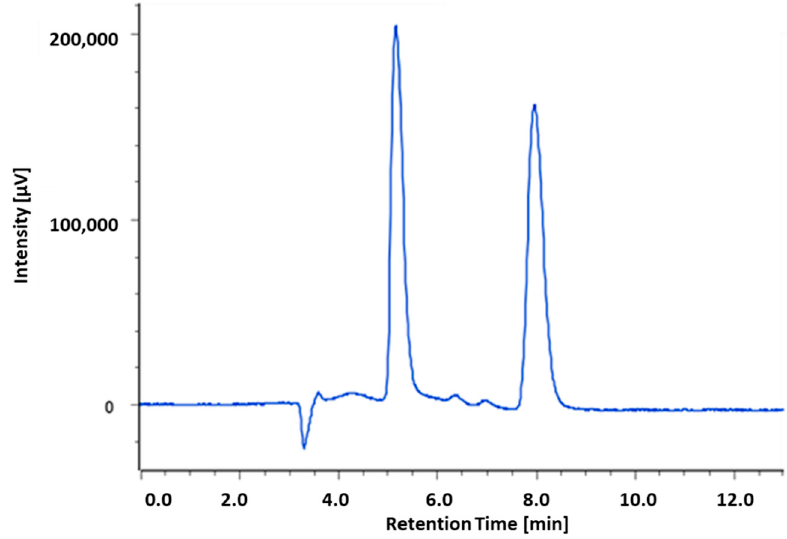
Figure 2. Chromatographic profile of ( 2R,3R/2S,3S )- 13 . Chiralpak IC (4.6 mm I.D. × 250 mm), n -Hex/IPA/TFA 50:50:0.3 ( v / v / v ), flux: 1 mL/min, 25 °C, λ = 220 nm. Injection volume: 10 µL (1 mg/mL in IPA).